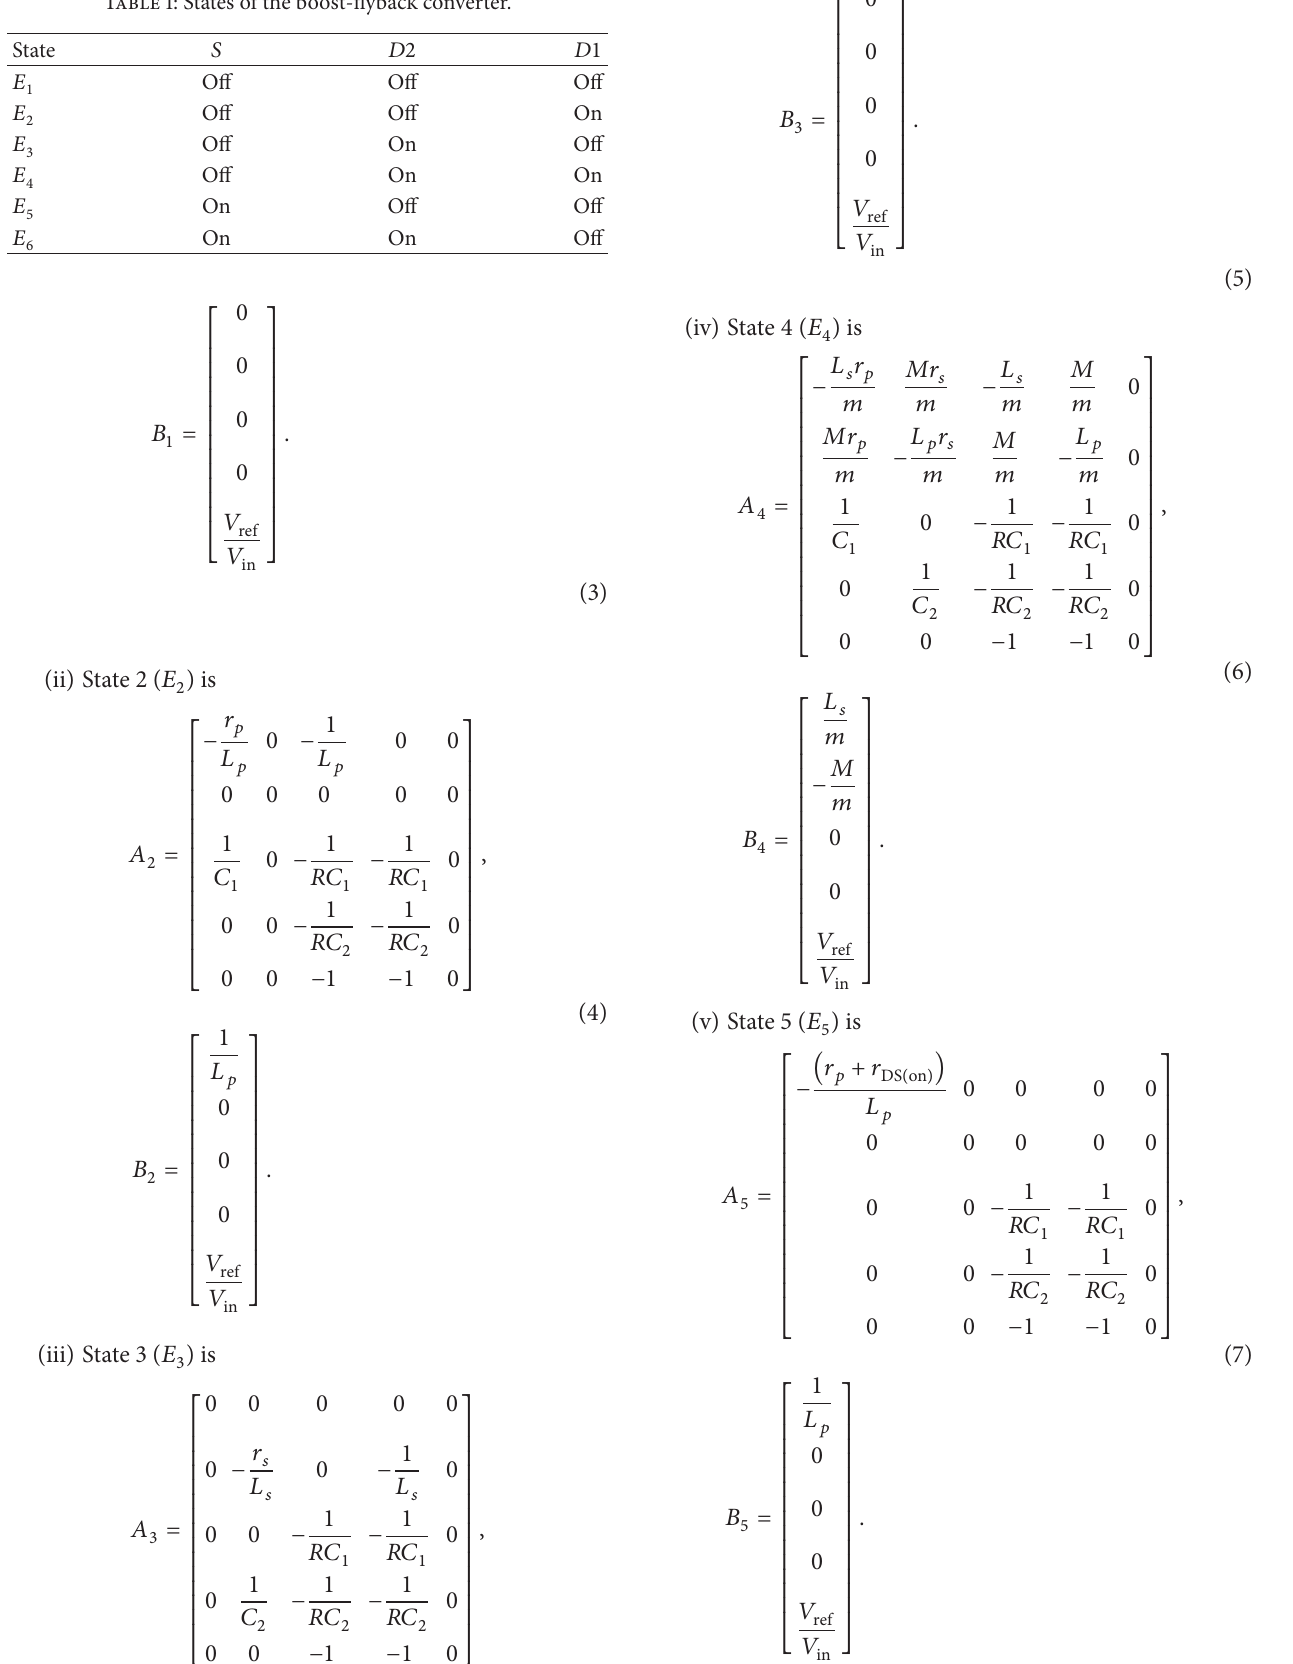
Table 1: States of the boost-flyback